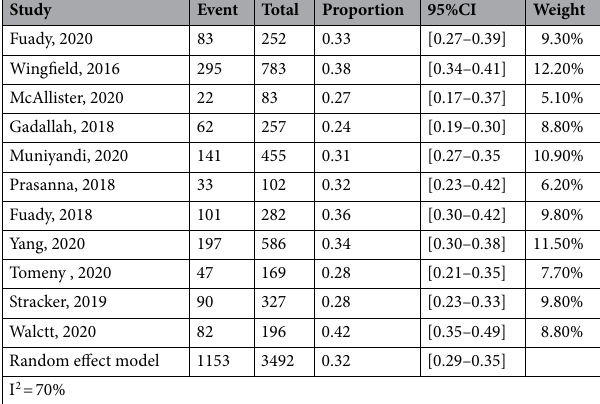
Table 2. Pooled proportion of catastrophic costs at 20% among drug